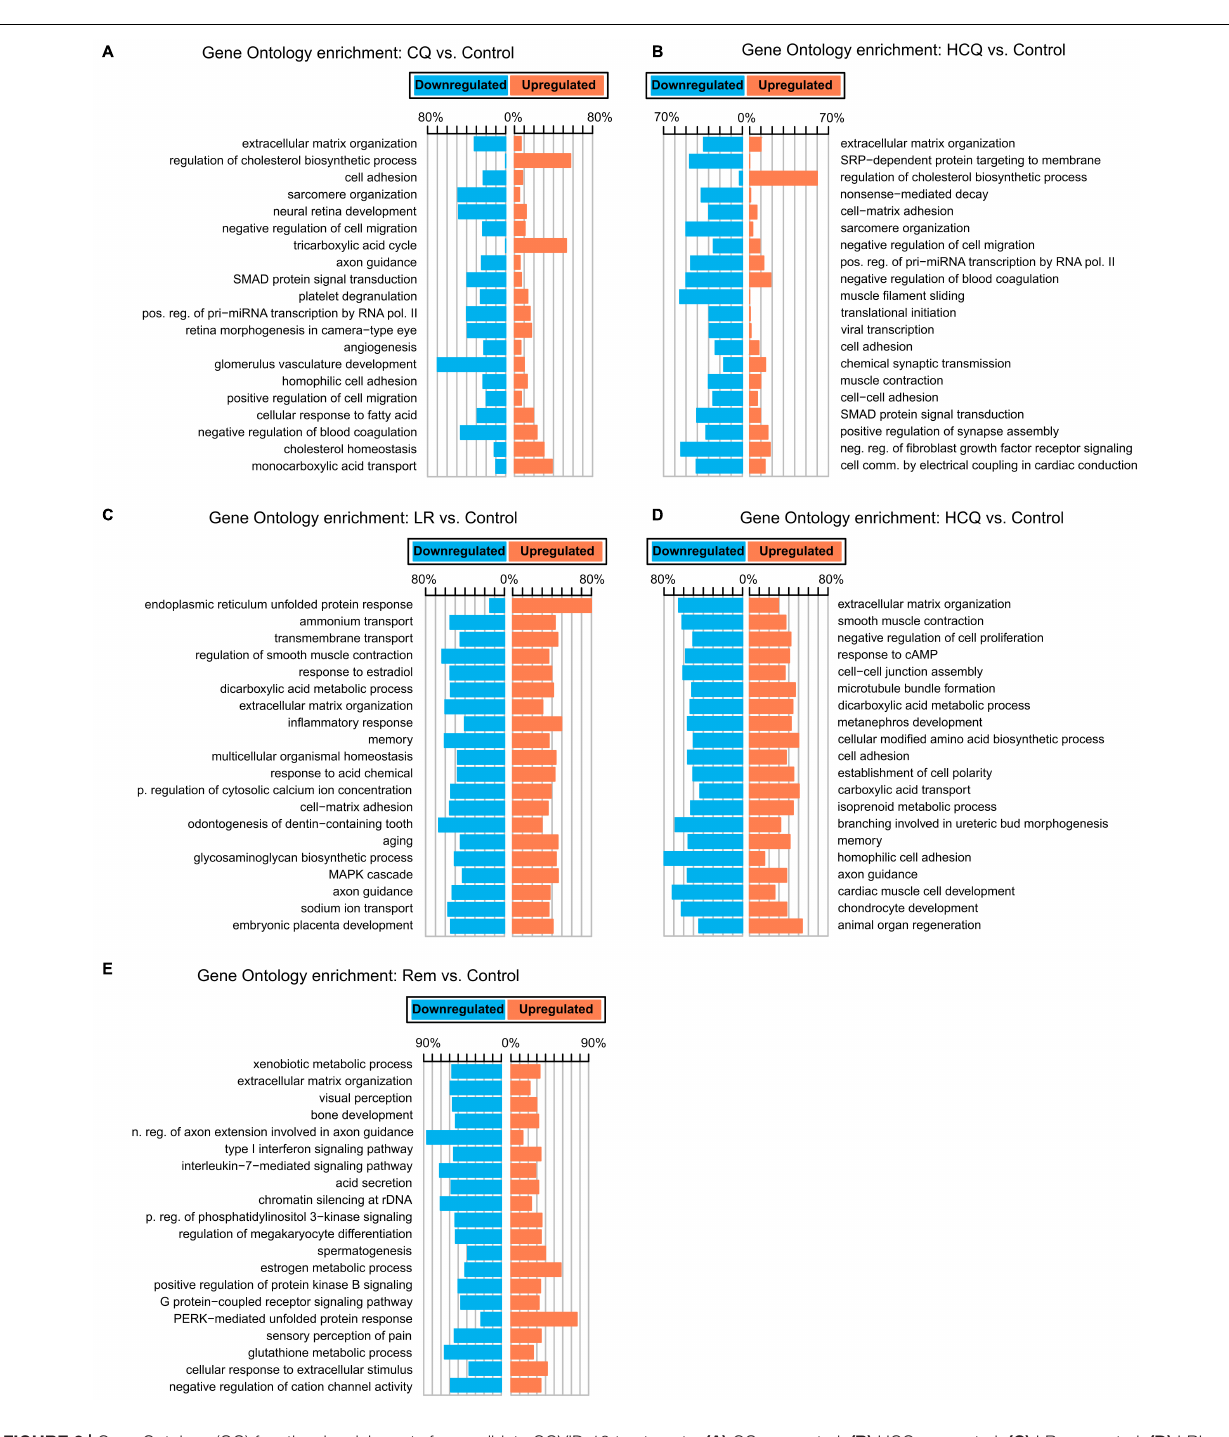
show significant downregulation after Rem treatment but are upregulated after LR and LRI treatment. To validate our findings, we performed qRT-PCR on a set of eight ER stress response genes and found, in line with the RNA-seq data, upregulation of